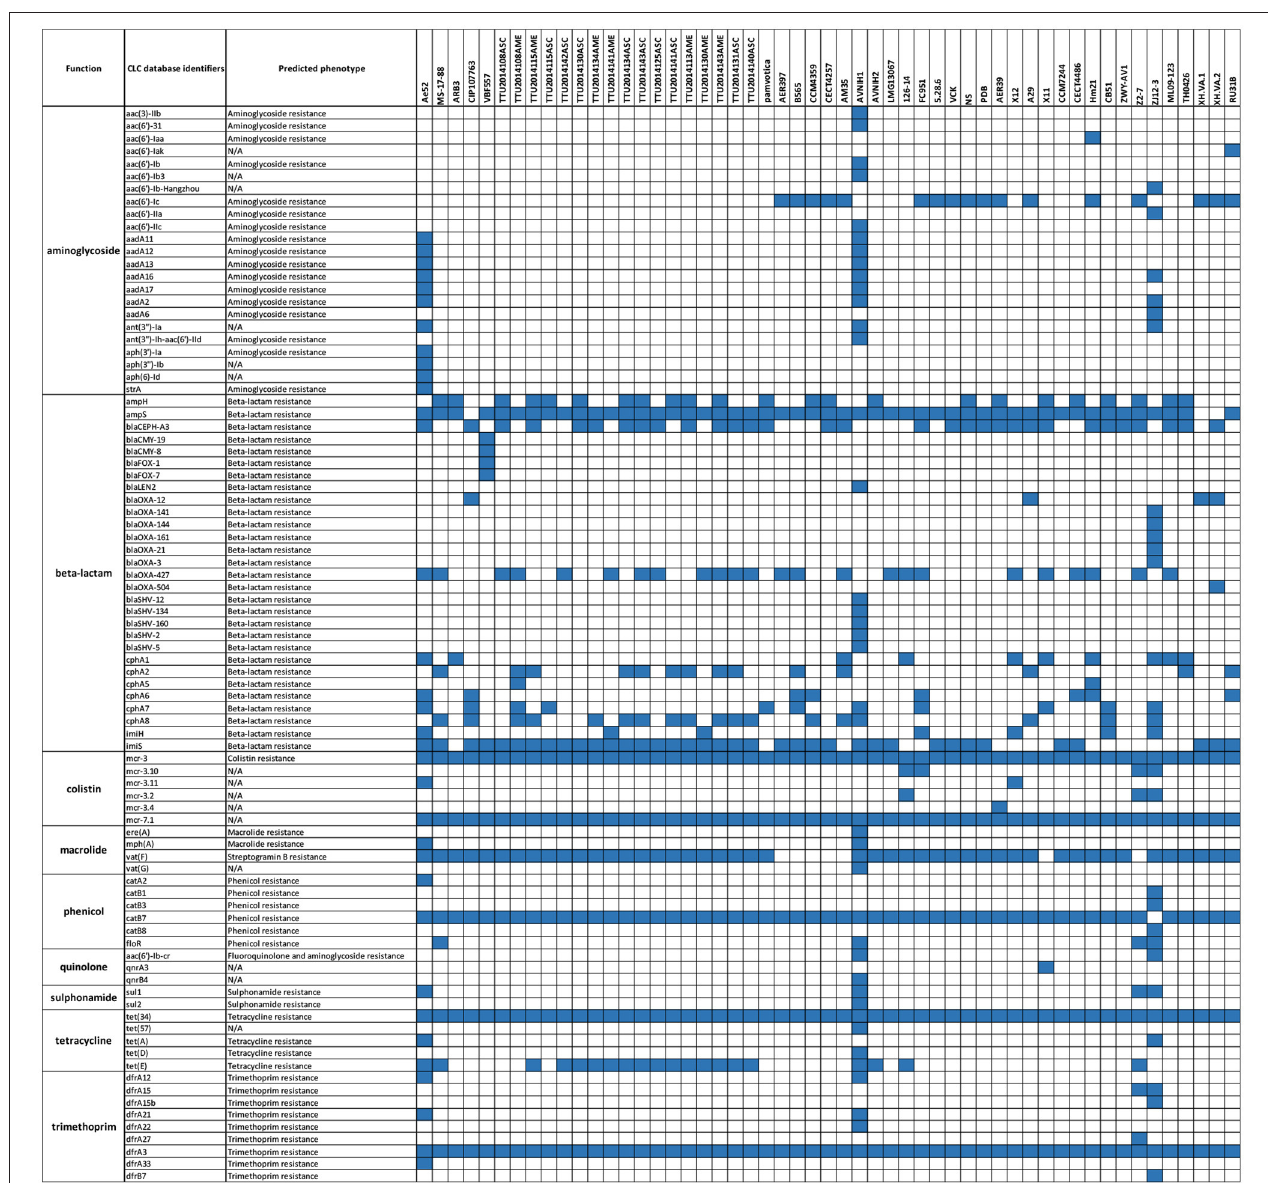
FIGURE 6 | AMR genes distribution across the 53 A. veronii genomes. Blue color represents presence of the gene.